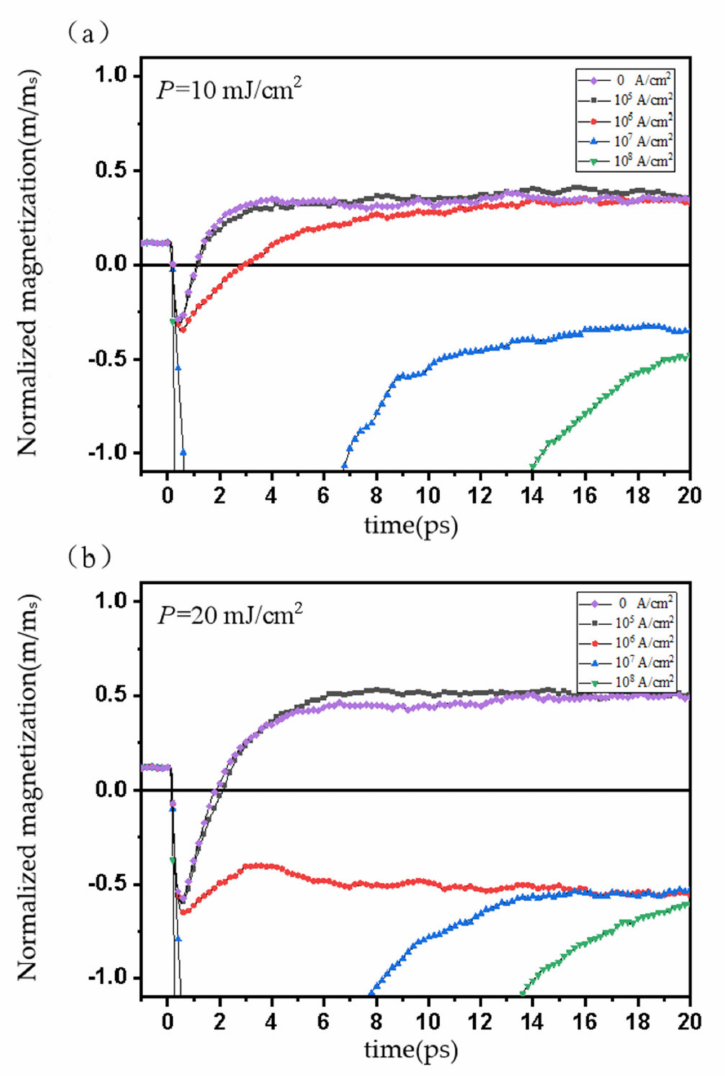
Figure 4. Normalized magnetization of Gd 25 Fe 75 alloy induced by different incident laser power density and injection current density, the current density ranges from 0~10 8 A/cm 2 . ( a ) when the incident laser power density is 10 mJ/cm 2 ; ( b ) when the power density of the incident laser is 20 mJ/cm 2